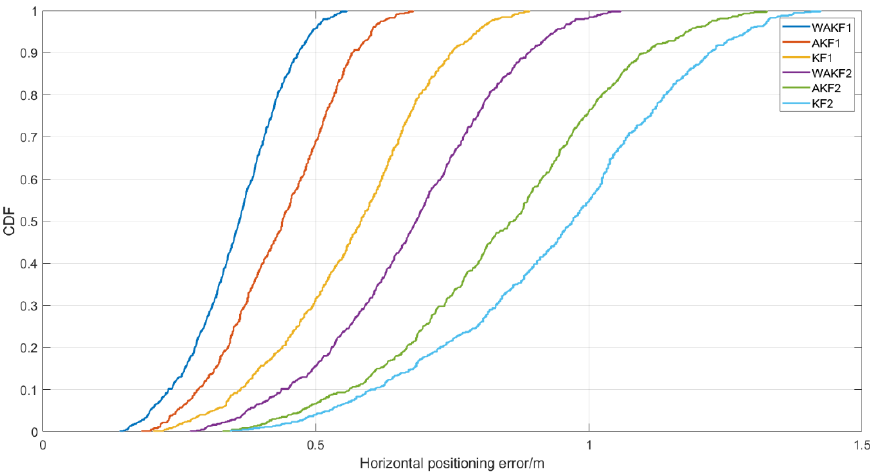
Figure 13. The positioning accuracy error in the horizontal direction.